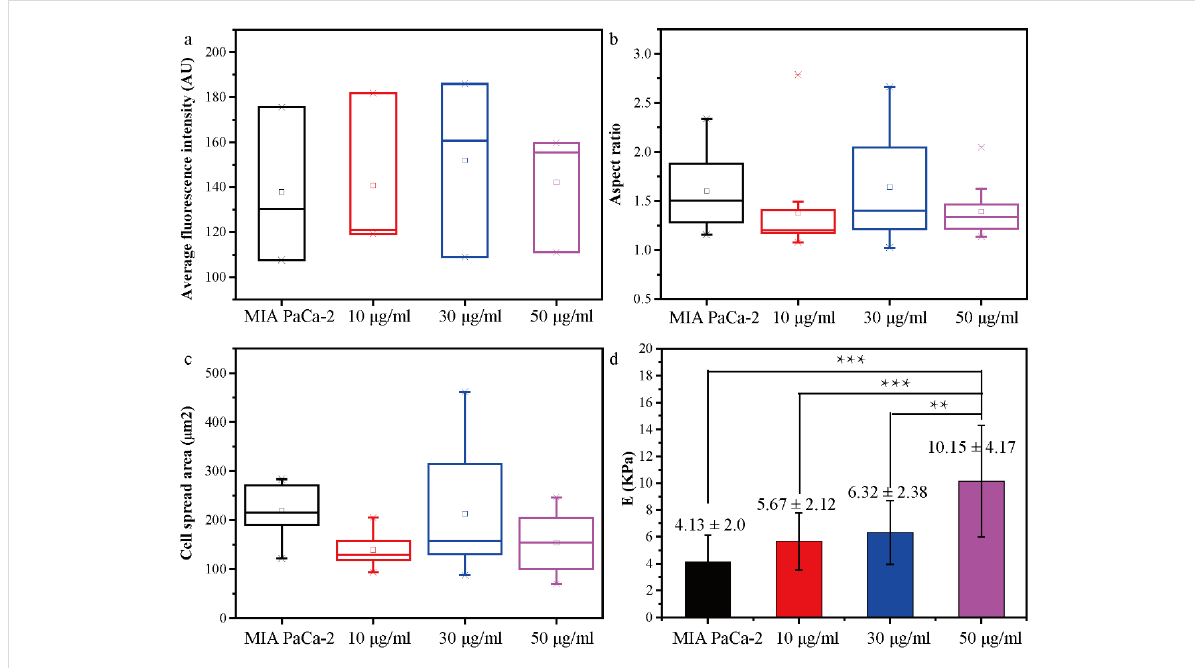
Figure 6: The statistic comparison of the nanostructure and the nanomechanical properties of MIA PaCa-2 cells treated with different concentrations of DOX. (a) The average fluorescence intensity of the cytoskeleton, (b) aspect ratio, (c) cell spread areas and (d) the corresponding Young's modulus of MIA PaCa-2 cells with/without DOX